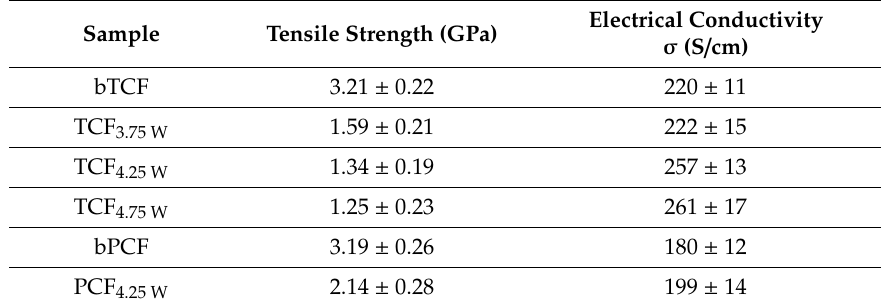
Figure 9. Single carbon fiber tensile strength for all irradiated samples. Table 2. Tensile strength and electrical conductivity ( σ ) of all irradiated